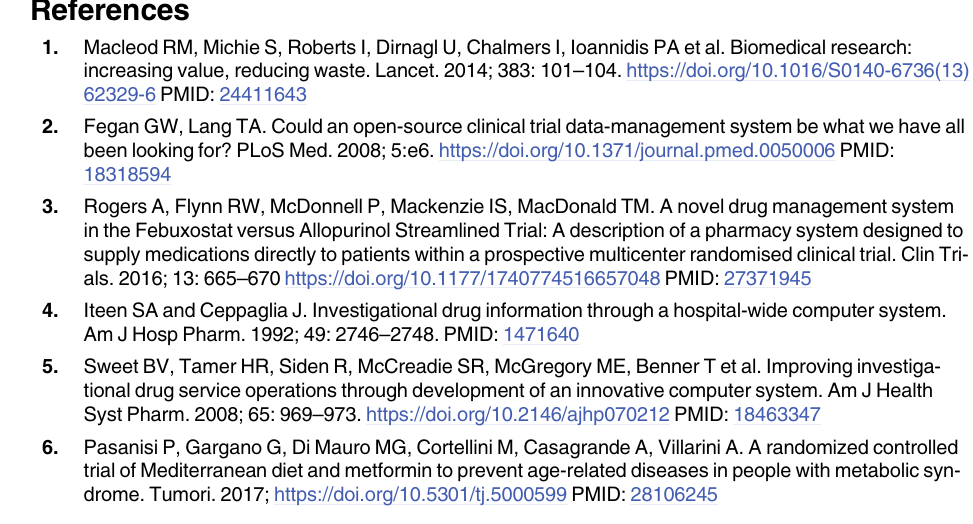
S2 Fig. The encrypted screen. The first column shows the bottle number, the second column shows the randomization block, and the third column shows the encrypted code about metfor- min/placebo